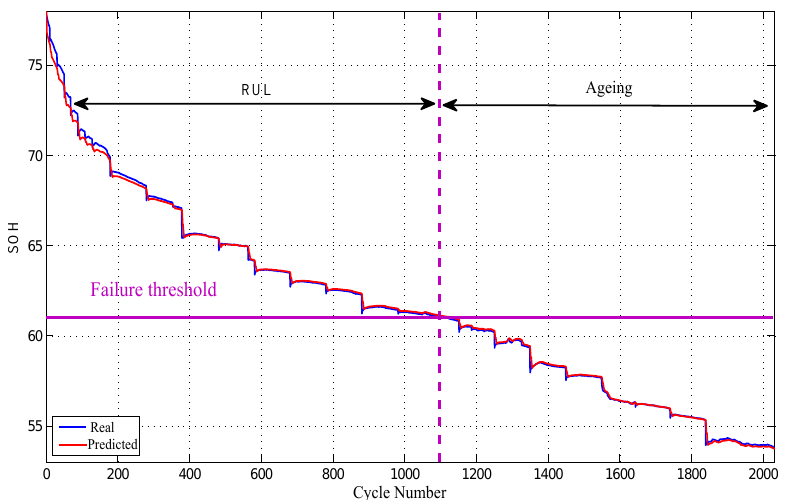
Figure 13. Evolution of the